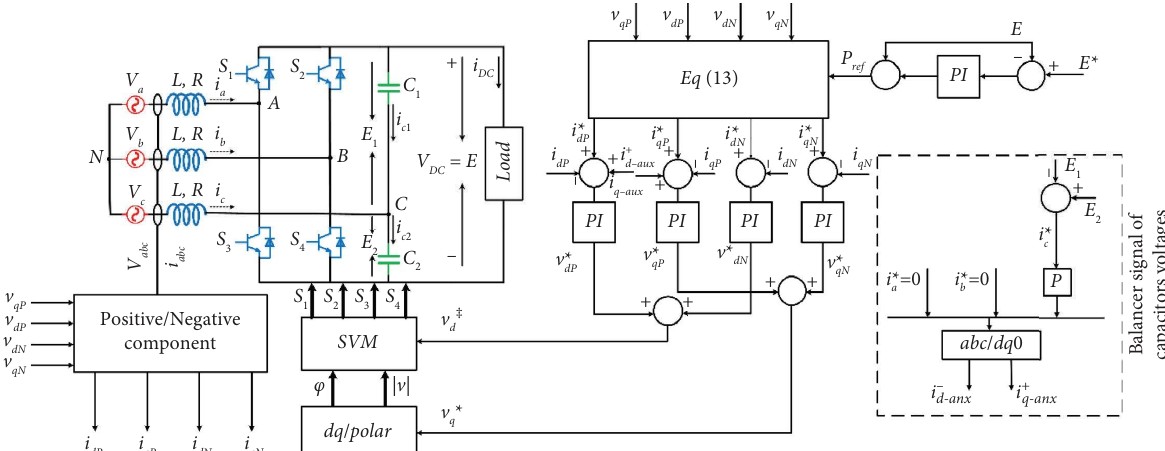
Figure 4: Block diagram of the proposed controller for FSTPR under unbalanced grid voltage.